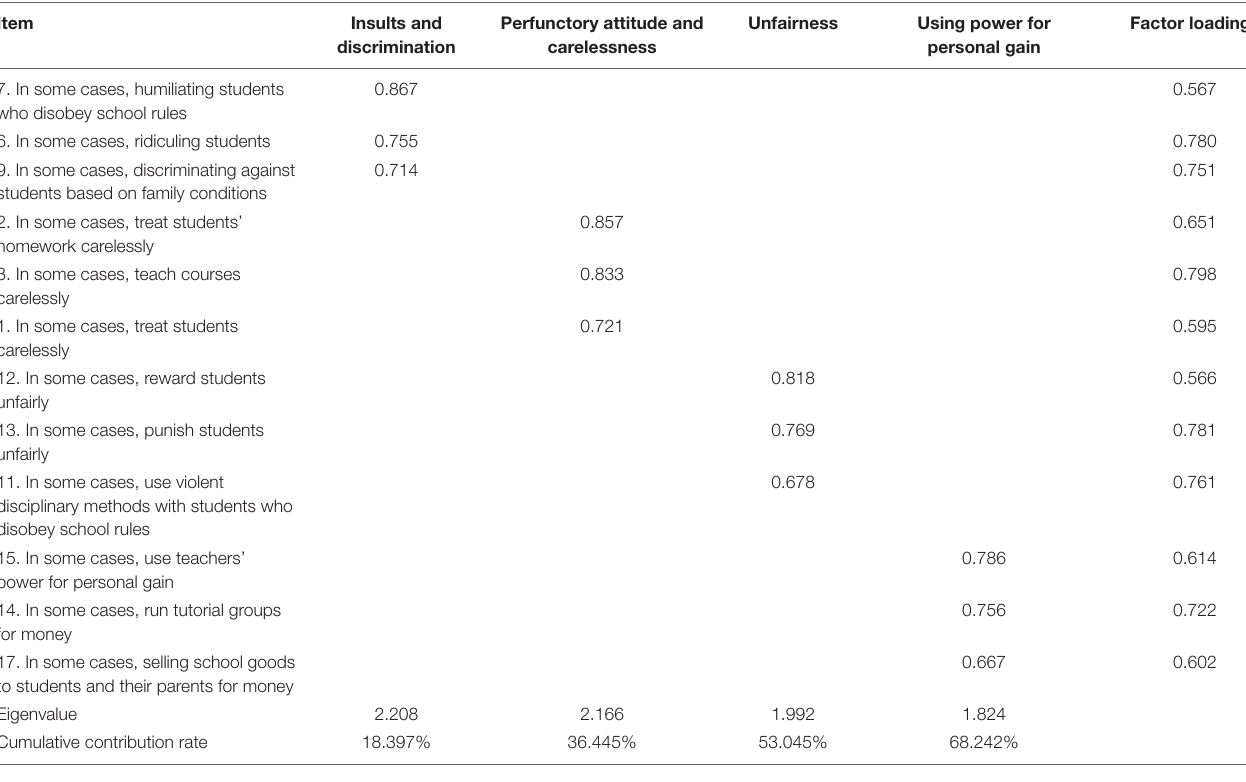
TABLE 2 | The 12-item unethical professional behavior tendencies scale EFA results.